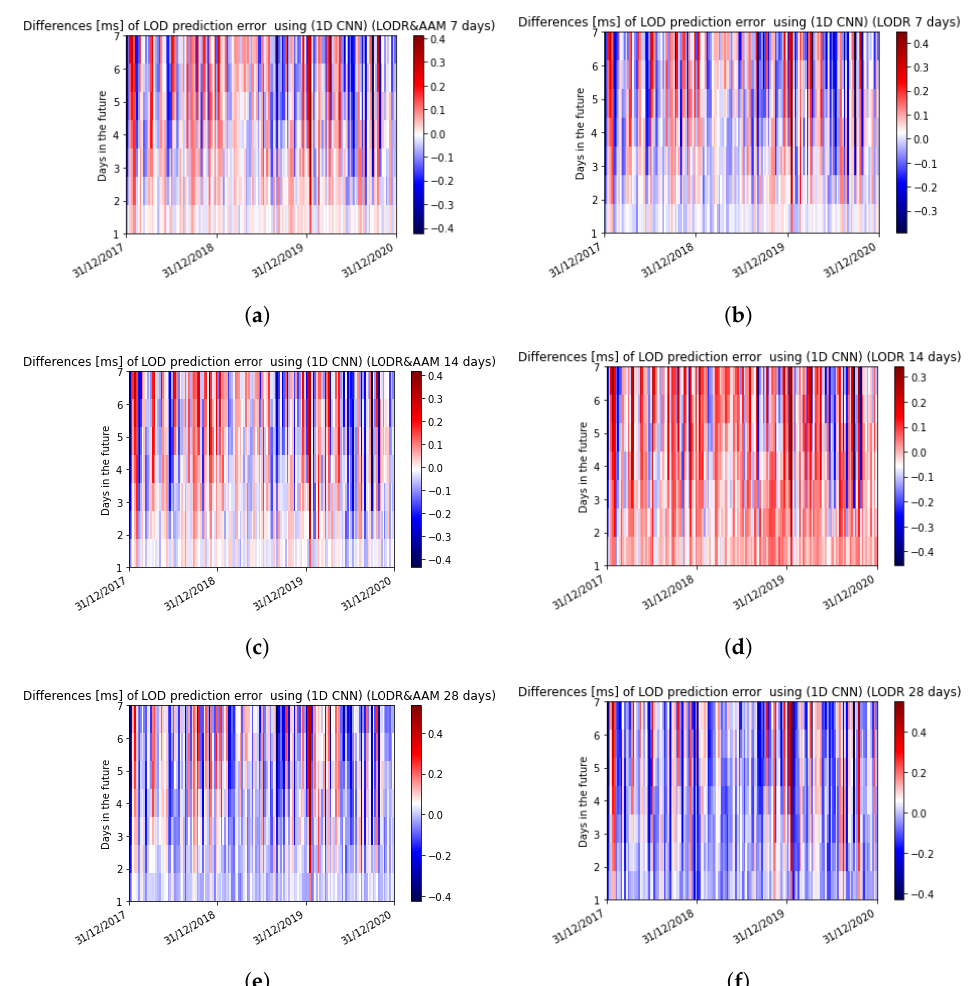
Figure 7. Errors of the predicted LOD with 7, 14, and 28 prior days before and after introducing the AAM using the 1D CNN. ( a ) LOD prediction error using 7 prior days after introducing the AAM; ( b ) LOD prediction error using 7 prior days; ( c ) LOD prediction error using 14 prior days after introducing the AAM; ( d ) LOD prediction error using 14 prior days; ( e ) LOD prediction error using 28 prior days after introducing the AAM; ( f ) LOD prediction error using 28 prior days.